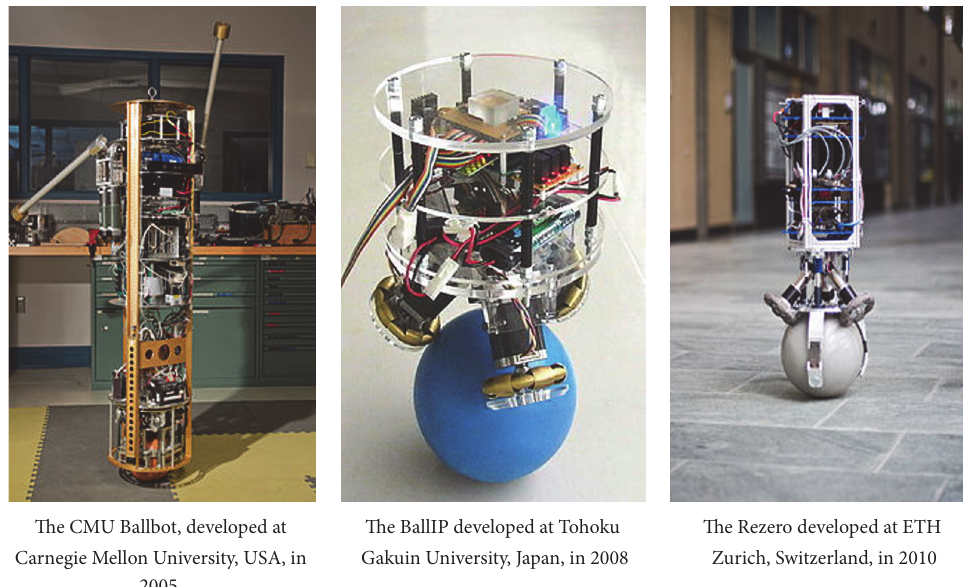
Figure 1: Various generations of spherical wheel developed recent robots.